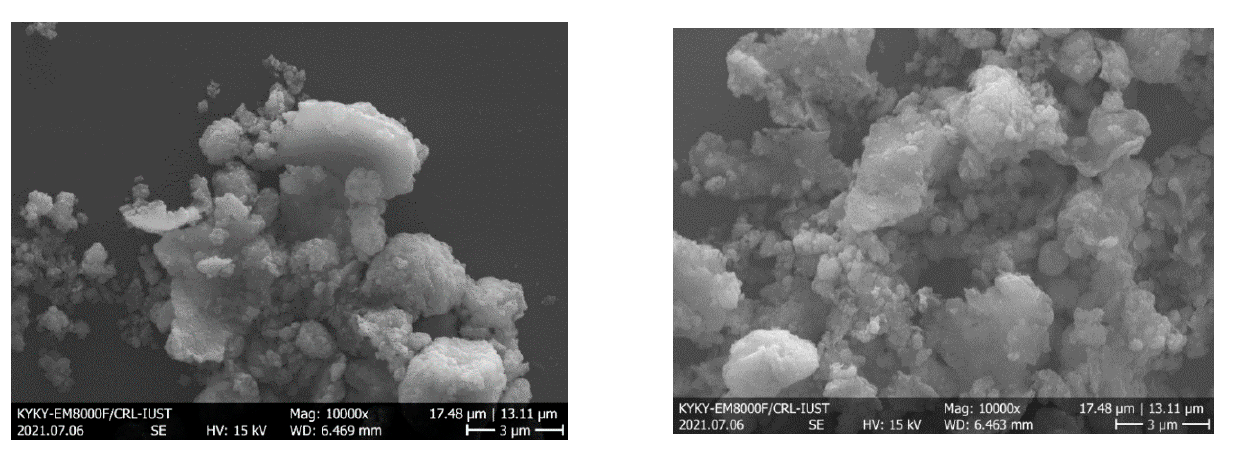
Figure 3. The LDH FE-SEM images.